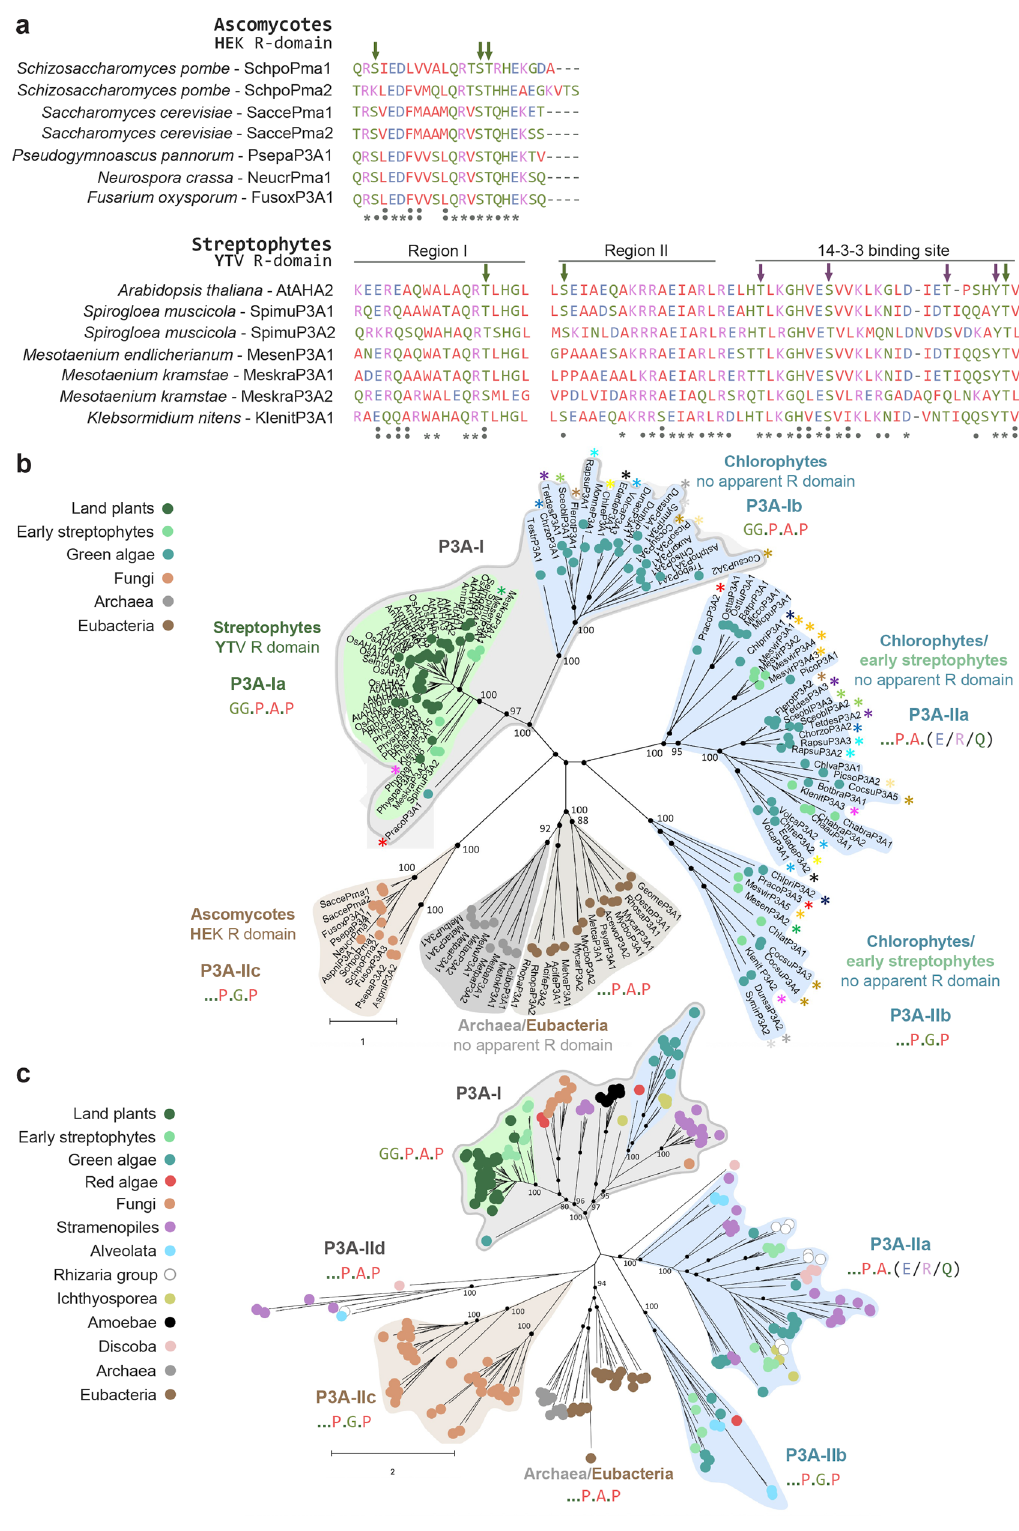
gene encoding the plant PM H + -ATPase was expressed on glucose. A fraction of the produced AHA2 is phosphorylated in yeast at the penultimate threonine residue, which promotes interaction with yeast endogenous 14 ‑ 3 ‑ 3 protein and thereby activates the pump 30 . As a negative control, we, therefore, expressed the mutant protein aha2T947A, which behaves as the WT pump but cannot be phosphorylated at the 947th